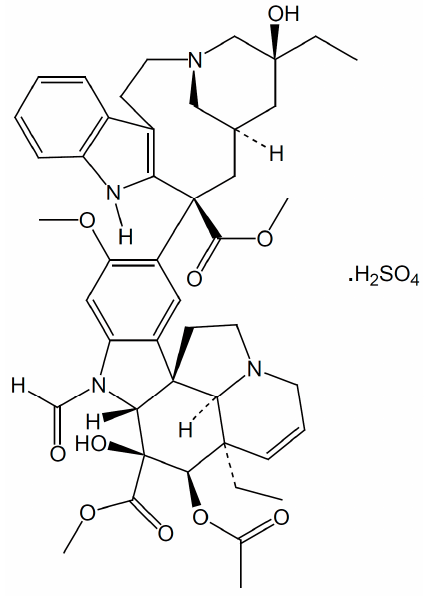
Figure 1. The structure of vincristine. Several studies have reported vincristine’s effects on platelet function in humans and animals. Steinherz et al. reported platelet dysfunction in vincristine-treated patients,